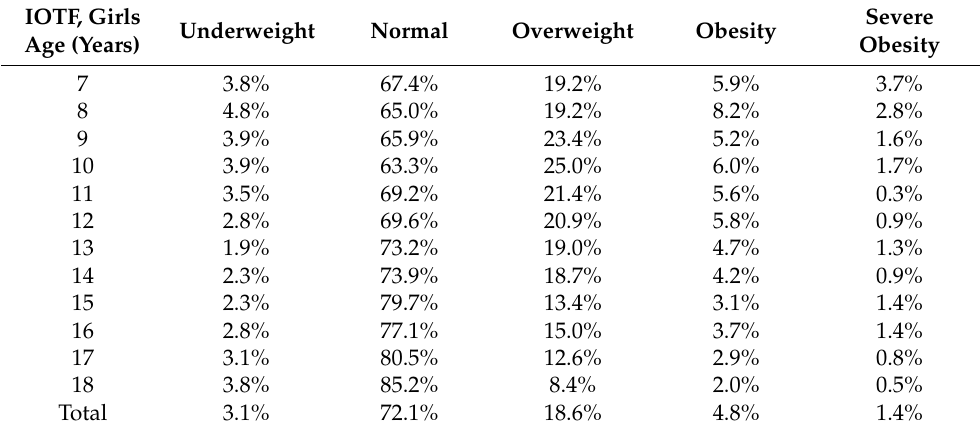
Table 10. Underweight, overweight and obesity prevalence in girls, according to the age, using IOTF